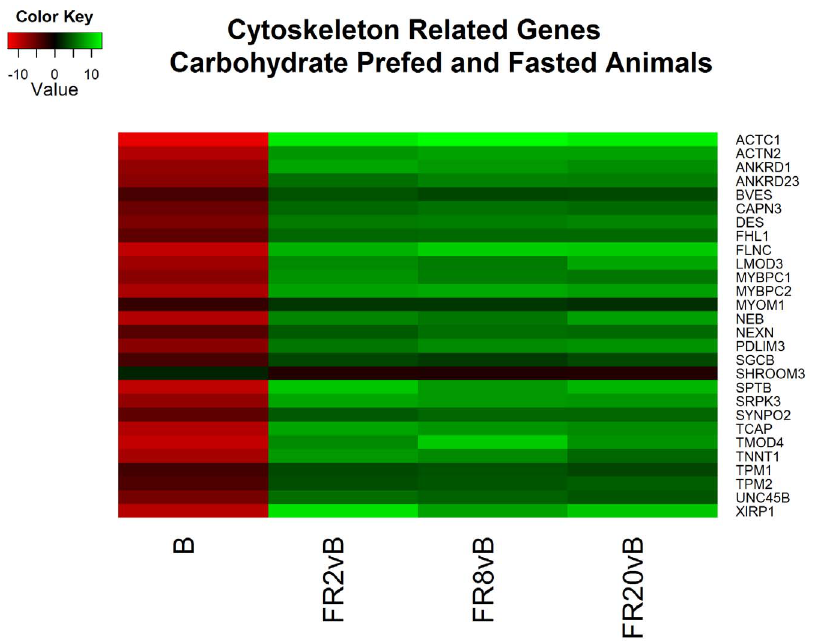
Figure 3. Heatmap of log2 fold changes of genes associated with cytoskeleton processes between carbohydrate prefed (CPF) and fasted (FS) animals. Rows are differentially expressed genes (DEGs) following RNA sequencing. Columns denote the respective timepoints Baseline (B), 2 hours full resuscitation change from Baseline (FR2vB), 8 hours full resuscitation change from Baseline (FR8vB), and 20 hours full resuscitation change from Baseline (FR20vB). Green denotes higher concentration or larger changes in mRNA concentration in CPF whereas red denotes the opposite.